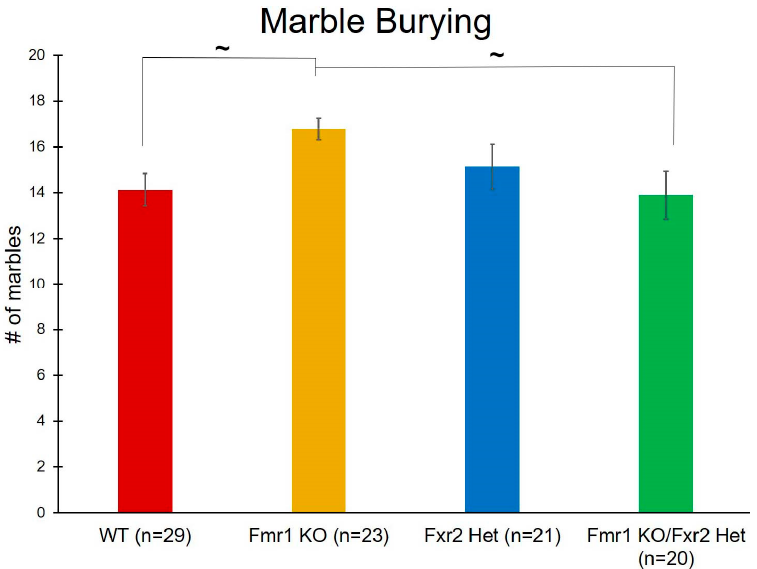
Figure 4. The number of marbles buried is a measure of repetitive behavior. We found a near statistically significant effect of genotype ( p = 0.052). Post-hoc tests revealed that Fmr1 knockout (KO) mice tended to bury more marbles than wild-type (WT) ( p = 0.095) and Fmr1 KO/ Fxr2 Het ( p = 0.098) mice. Each bar represents the mean ± SEM for the number of mice indicated on the figure. ~, 0.05 ≤ p ≤ 0.10.